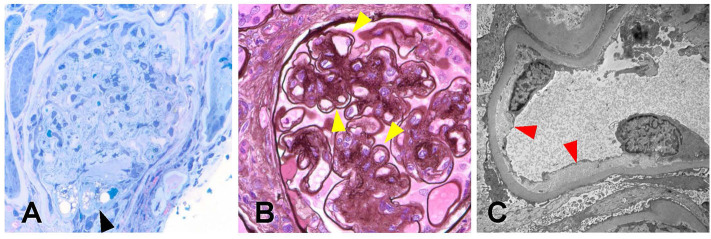
Biopsy findings in patient 1 with diabetic retinopathy and nephropathy treated with bevacizumab and subsequent thrombotic microangiopathy. (A) One glomerulus showed segmental luminal obliteration by insudates and lipid, with adherence to Bowman's capsule consistent with segmental glomerulosclerosis (arrowhead, methylene blue stain, 400×). (B) Few glomeruli demonstrated segmental duplication of glomerular basement membranes (arrowhead, Jones methenamine silver stain, 400×). (C) Ultrastructural analysis revealed segmental subendothelial electron lucent widening, with very early duplication of basement membrane material (arrowheads, 20,000×). The light and ultrastructural findings were consistent with chronic thrombotic microangiopathy.